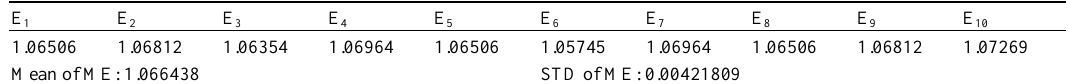
Table 4. Result of experiment 3 (ITC).